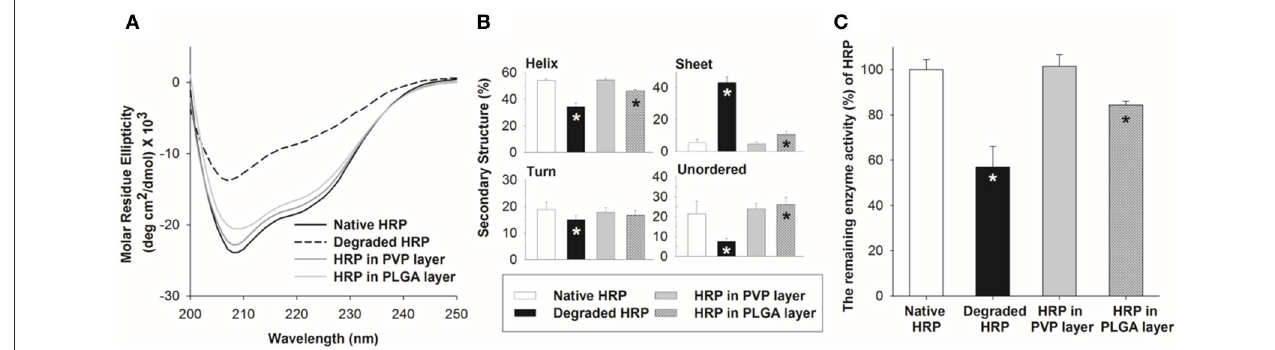
FIGURE 8 | Stability of HRP in polymer matrices upon spray deposition. (A) CD spectra of HRP in PVP and PLGA matrix. (B) Secondary structure compositions of HRP estimated from the CD spectra by the CDSSTR algorithm. (C) Relative enzyme activity of HRP in PVP and PLGA matrix. Asterisk (*) indicates a significant difference between a processed HRP sample and native HRP ( n = 3, p <